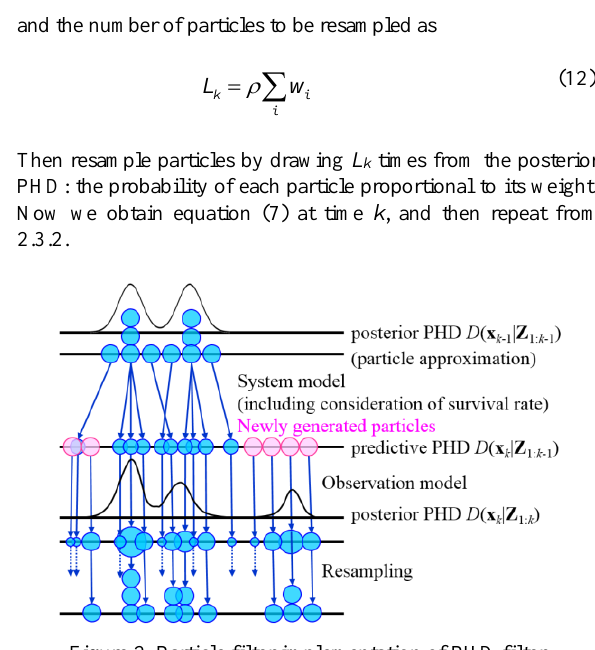
Figure 2. Particle filter implementation of PHD filter